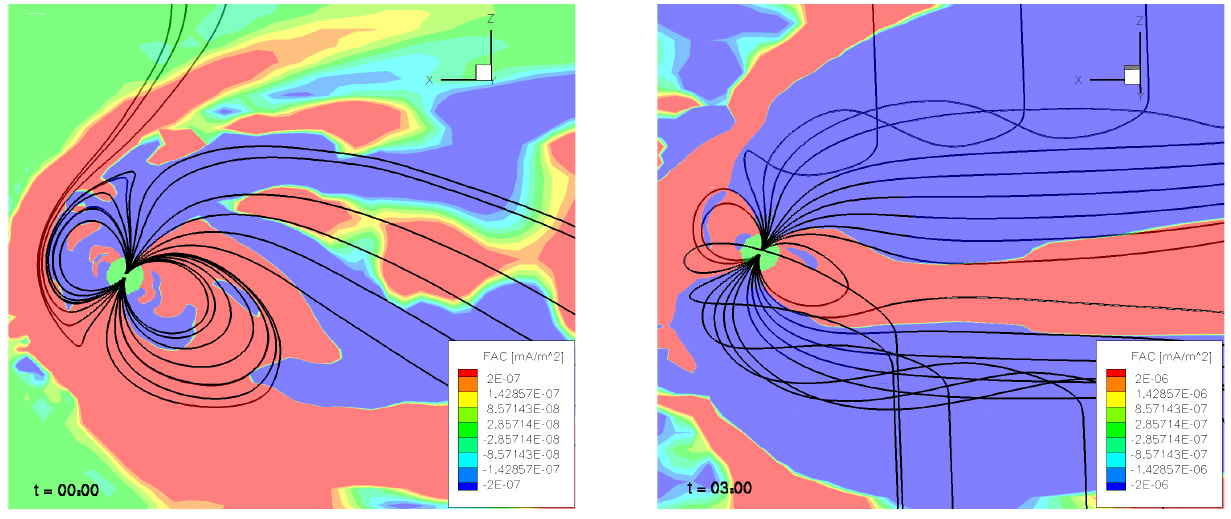
Fig. 8. Field line topology in the noon and midnight local time sectors at 5 ◦ MLat intervals in the magnetosphere at 00:00UT and 03:00UT. The background color coding shows the field-aligned current densities (mA/m 2 ) in the noon-midnight meridian plane. Positive (red) denotes parallel to the magnetic field and negative (blue) antiparallel